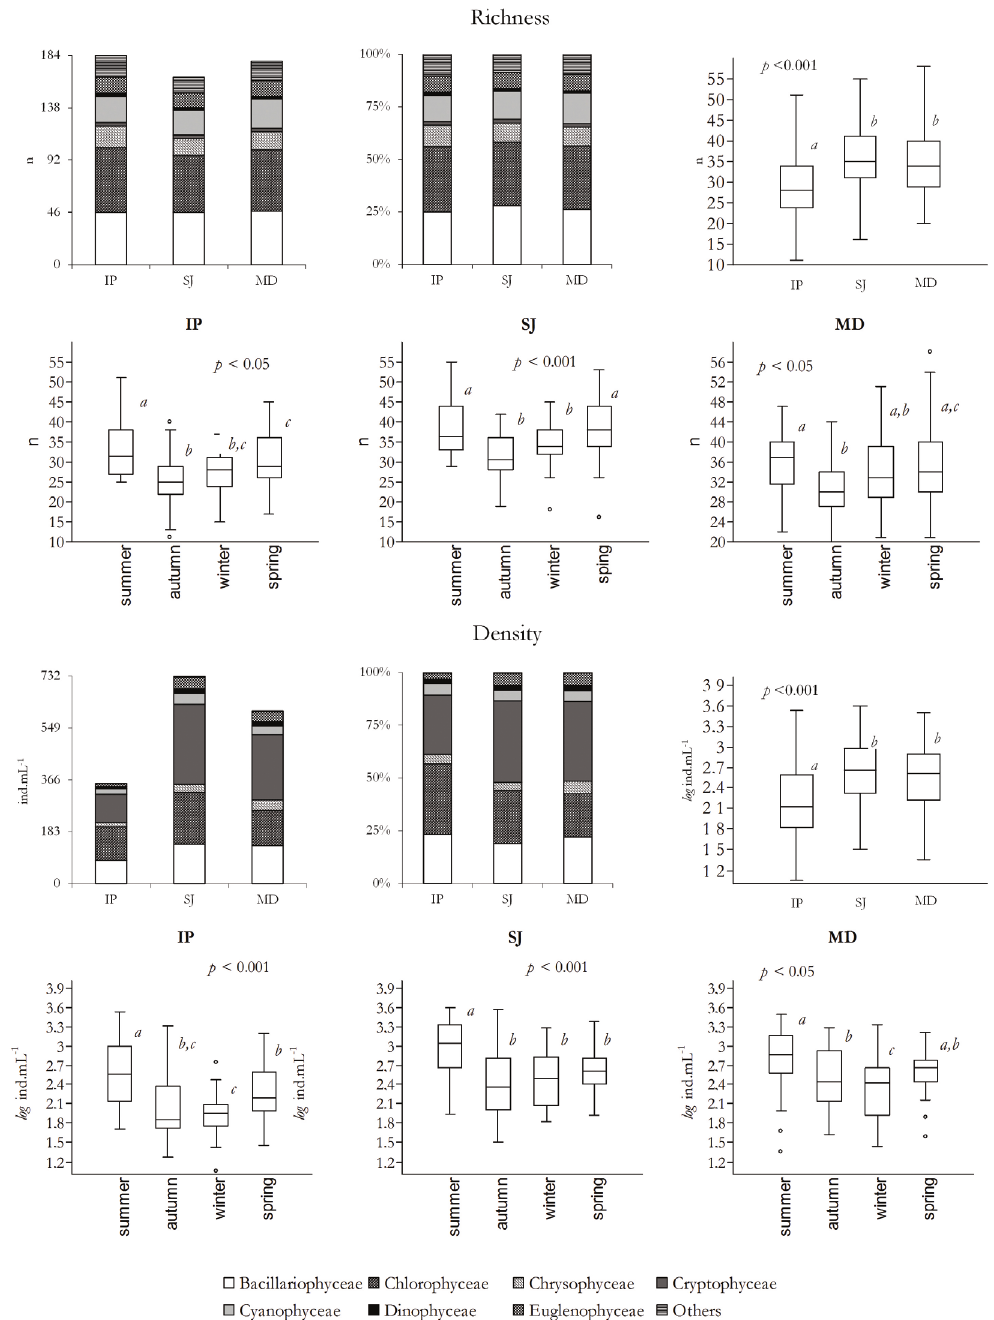
Figure 2. Absolute and relative contributions of taxonomic classes and sites and seasonal variations of richness and density of phytoplankton in Guaiba Lake; different letters indicate significant differences of values at p <